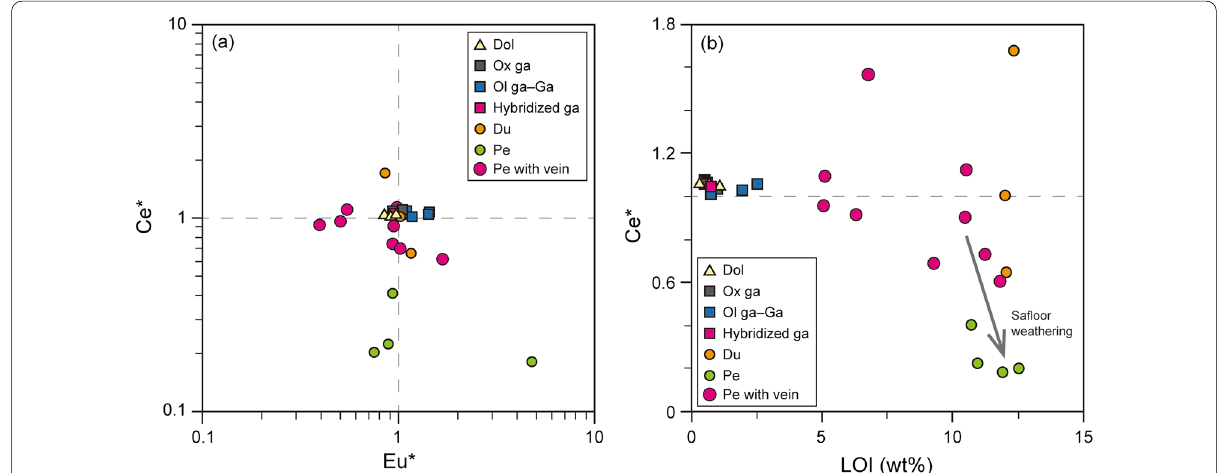
Fig. 9 Relationship between Ce*/Eu* and Ce*/LOI. Ce* and Eu* represent CI chondrite‑normalized ratios of Ce/(La respectively. CI chondrite values are after Sun and McDonough (1989). The abbreviations are the same with Fig.